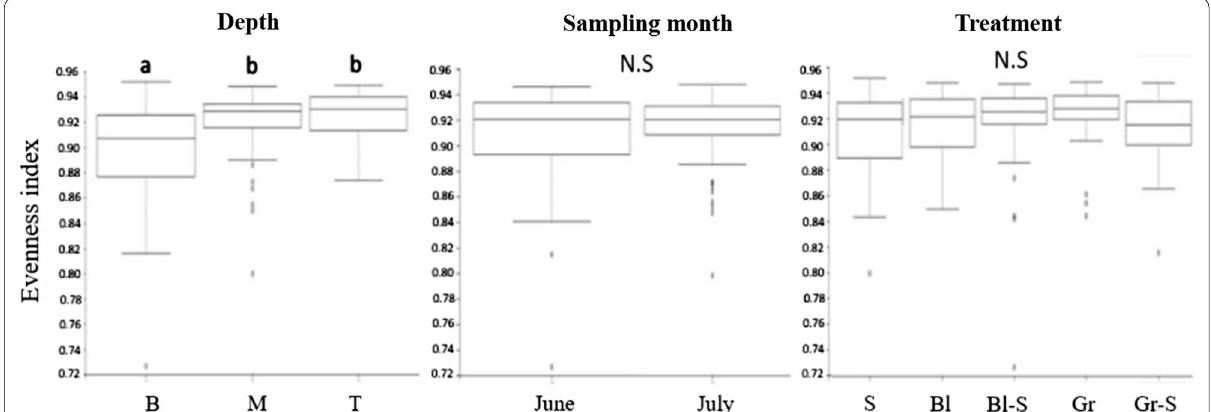
Fig. 3 Alpha diversity (evenness) of bacteria between different sampling depth, month, and mulch type in soil samples. B bottom, M middle, T top, S sawdust, Gr green weed mat, Gr-S sawdust topped with green weed mat, Bl black weed mat, and Bl-S sawdust topped with black weed